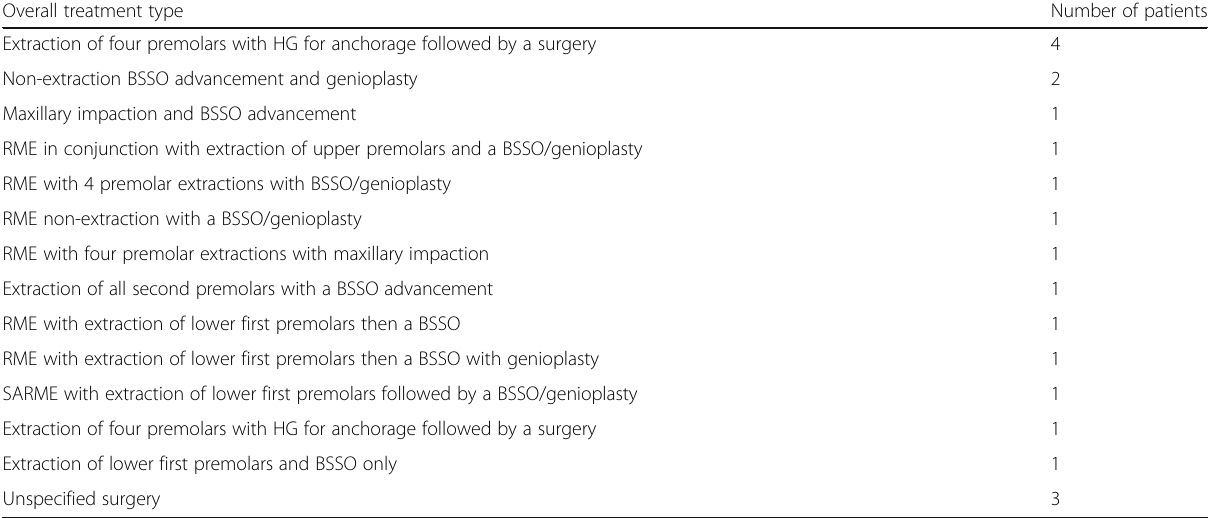
Table 3 Final treatment plan in the surgical treatment group Overall treatment